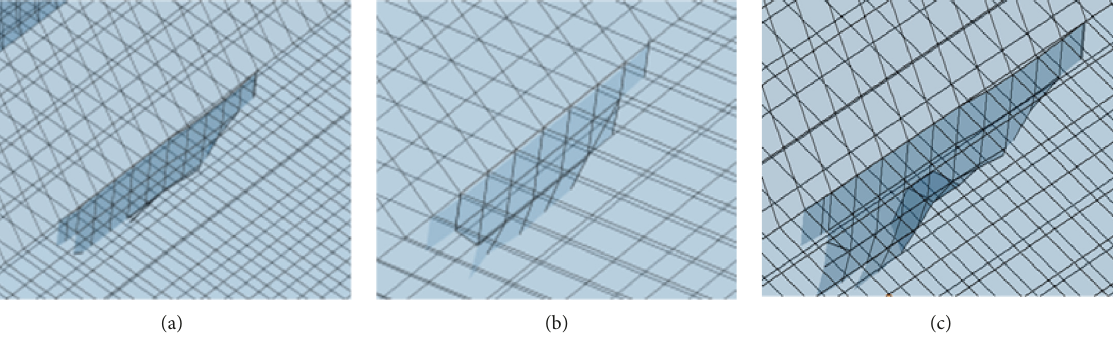
Figure 20: The morphology of crack propagation after the end of the cycle. (a) 2.5mm/10mm. (b) 2.5mm/15 mm. (c) 4